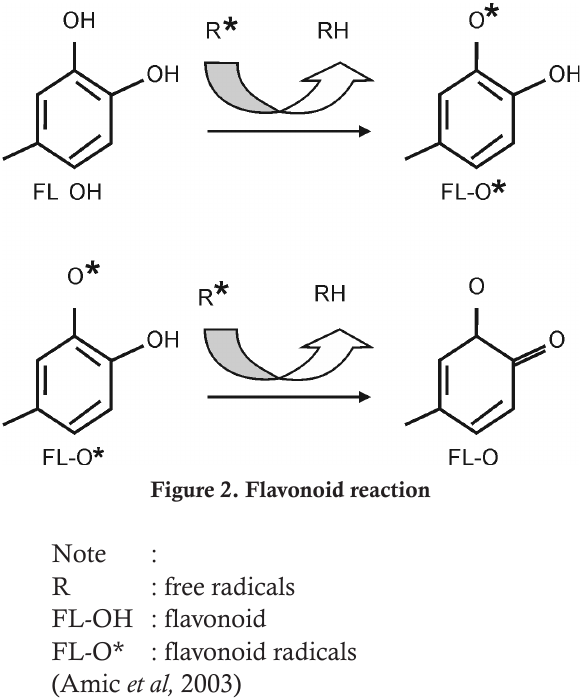
Figure 2. Flavonoid